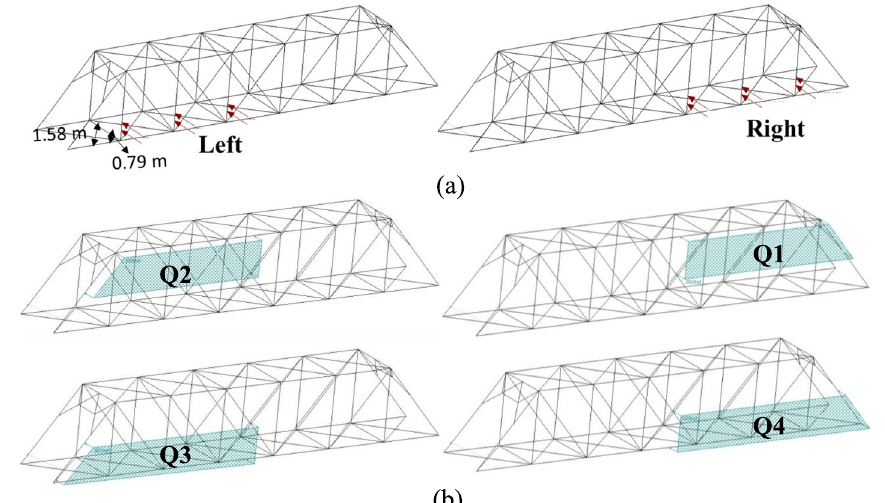
Fig. 6 Finite element model: a point load; b pressure load in a